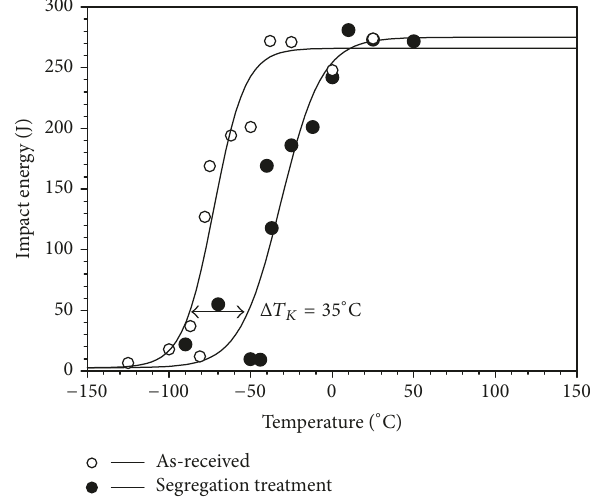
Figure 3: Ductile-to-brittle transition curves for 15Kh2NMFAA steel specimens: as-received and after segregation provoking treat-